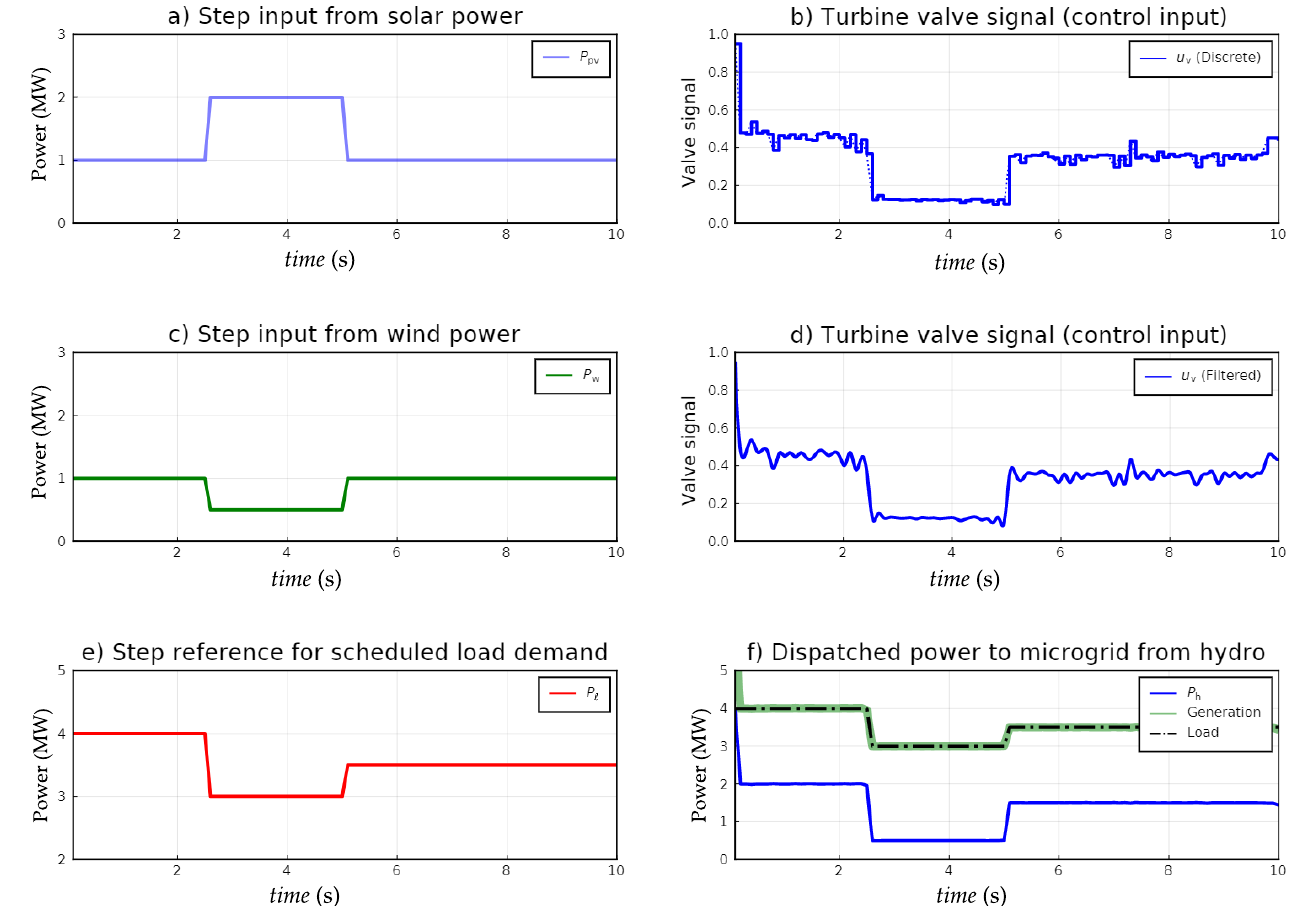
Figure 7. Setpoint tracking of scheduled load using step input from solar and wind power. Both the plant and model are represented by mathematical equations. The control input u v from the OCP is generated for grid frequency to be exactly at 314 rad/s for ∆ t c = 0.1 s. However, the actual plant is now out of control for the next 0.1 s at which period grid frequency fluctuates. Figure 7 shows the instantaneous (interpolated) dynamics of turbine valve signal which maintain frequency within the required limit as shown in Figure 8a with the blue